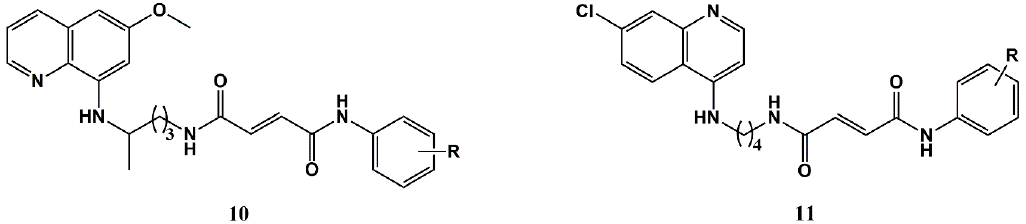
Figure 4 . Primaquine and chloroquine fumardiamides reported by Zorc and co-workers [62].